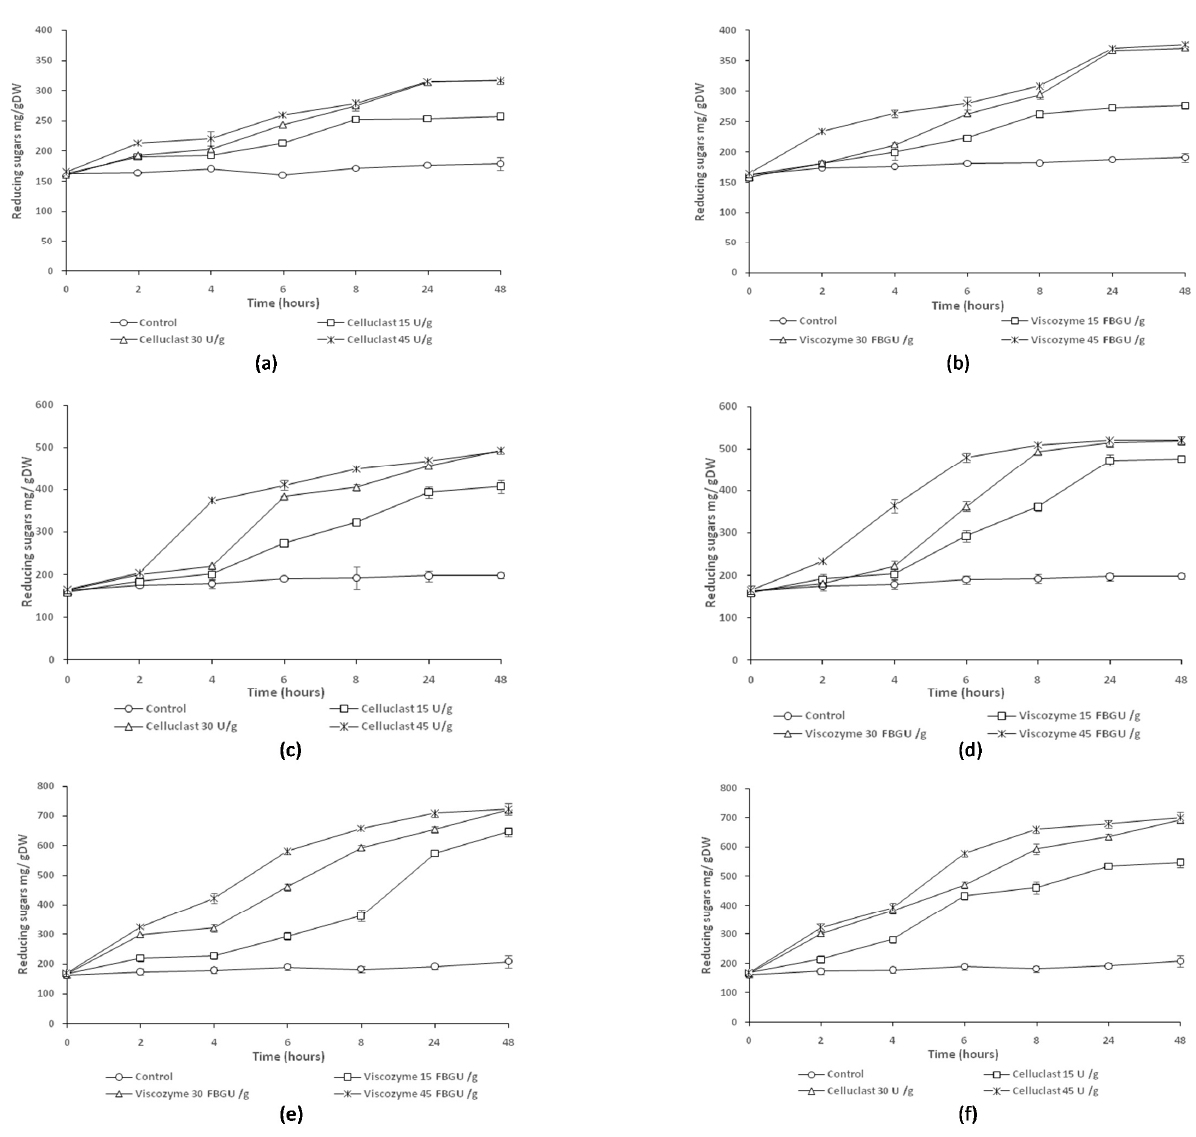
Figure 1. Analysis of enzymatic hydrolysis of argan pulp at three different substrate loadings (2% w / v , 5% w / v , and 10% w / v ), using Celluclast and Viscozyme at different concentrations monitoring the reducing sugar concentrations. ( a ) Pulp at 2% w / v using Celluclast, ( b ) pulp at 2% w / v using Viscozyme, ( c ) pulp at 5% w / v using Celluclast, ( d ) pulp at 5% w / v using Viscozyme, ( e ) pulp at 10% w / v using Celluclast, and ( f ) pulp at 10% w / v using Viscozyme.